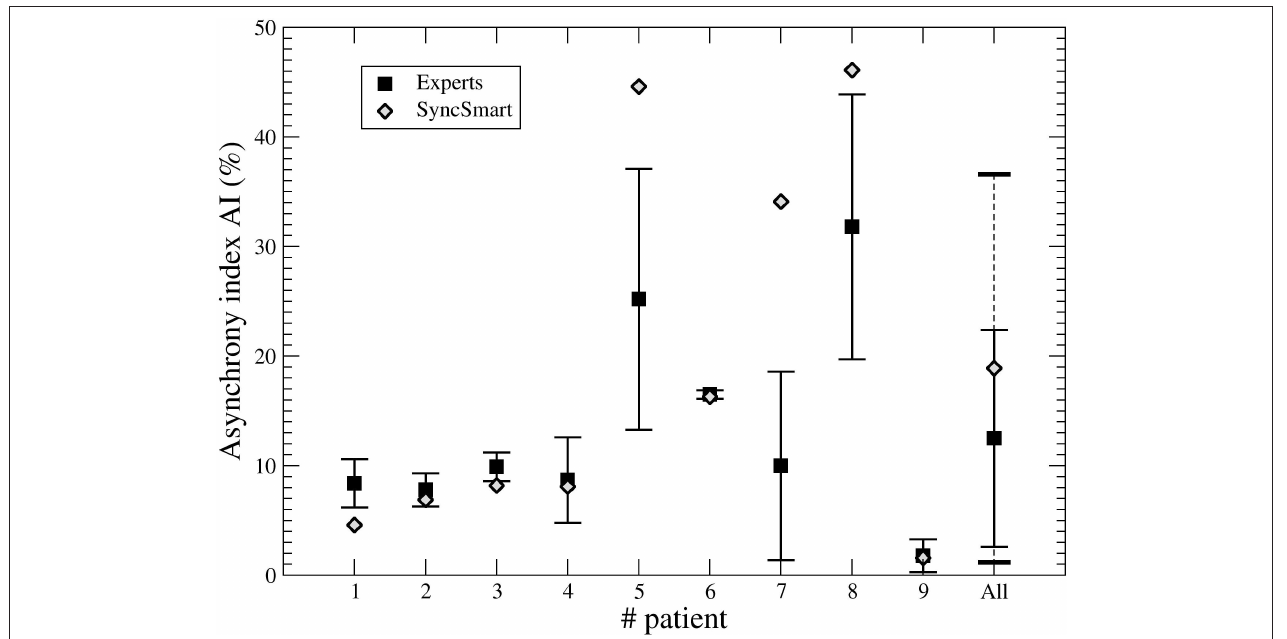
FIGURE 3 | Asynchrony index (AI) computed from the SyncSmart scoring and the mean AI (with the standard deviation) computed from the expert scorings for each patient and for all patients, respectively.